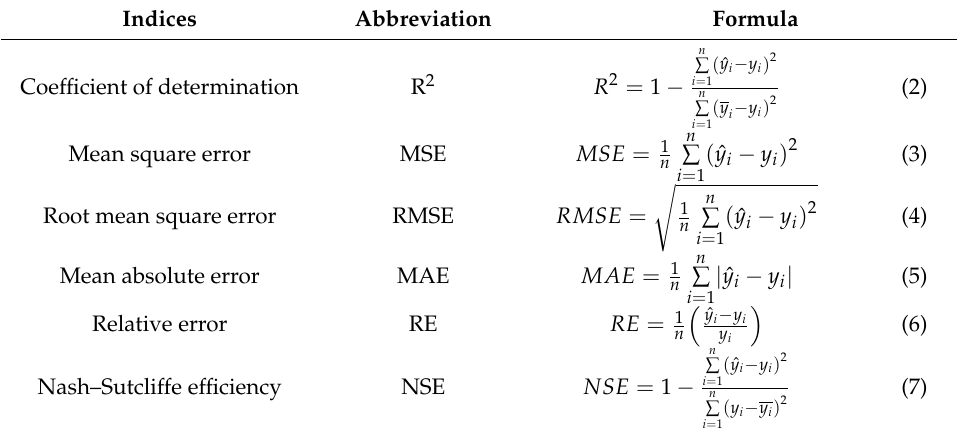
Table 3. Statistical and error metrics used for model